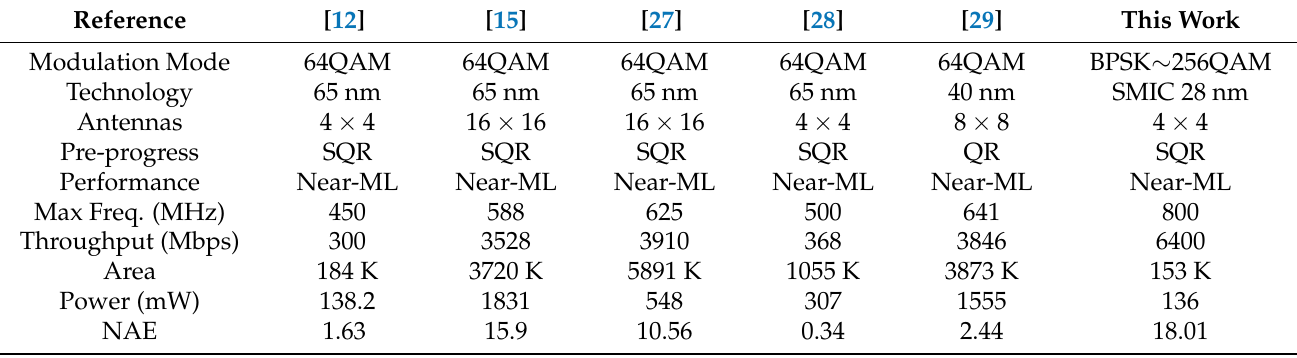
Table 3. Comparison of this paper’s results with other published K-best